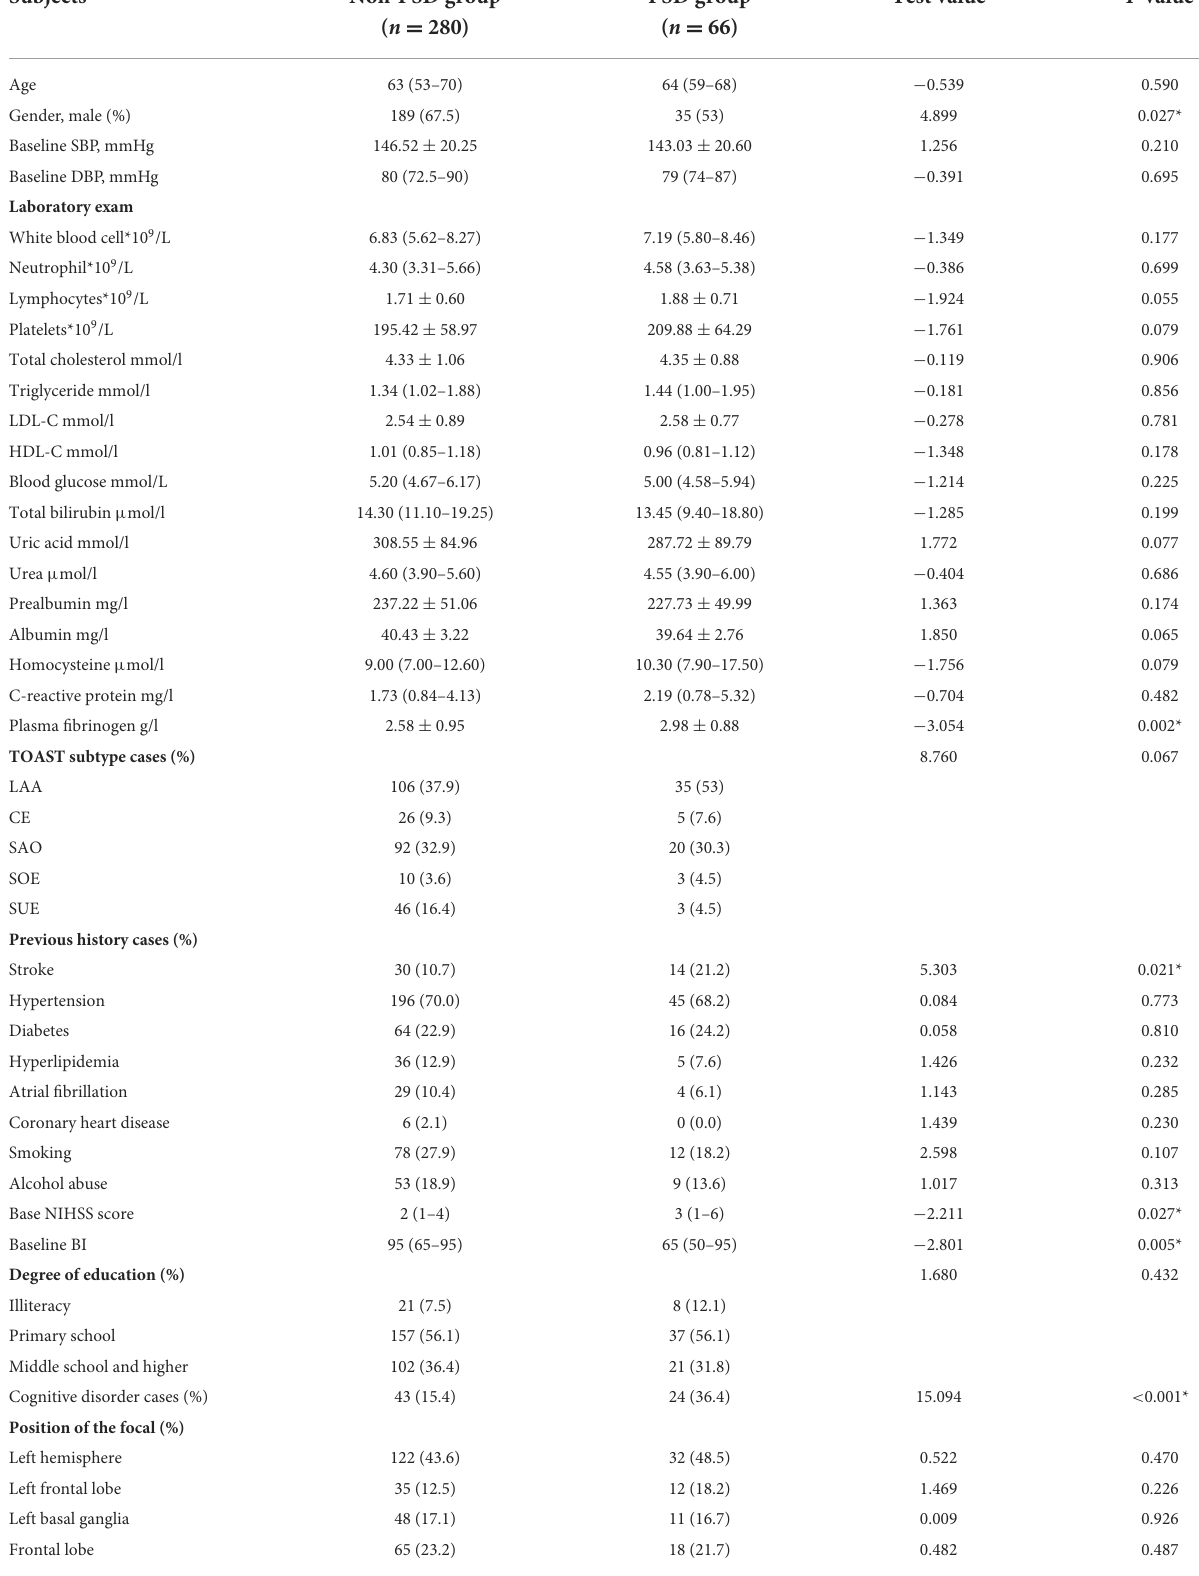
TABLE 1 Baseline characteristics of patients in the non-PSD and PSD